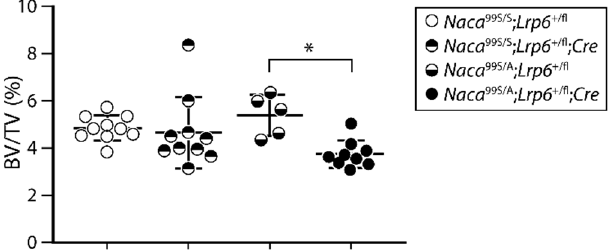
Figure 2. Naca and Lrp6 form part of a common genetic pathway regulating bone mass. Femurs of female mice were analyzed by μ CT at 3 months of age. BV/TV, bone volume/tissue volume. * p < 0.05, two ‐ way ANOVA with post hoc tests.